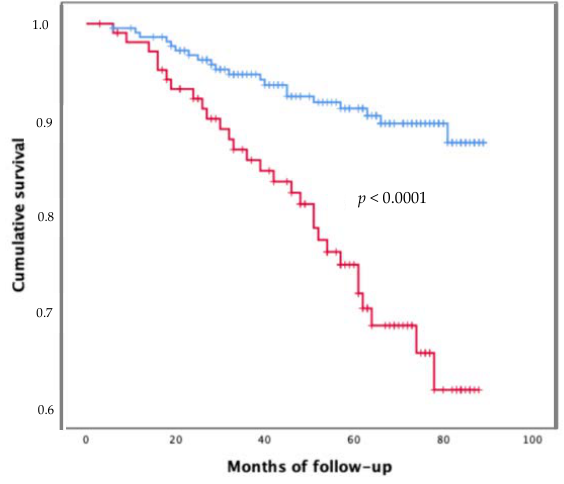
Figure 2. Survival curves of 324 C-P class A cirrhotic patients with gamma globulin < 1.8 gr/dl (blue line) and ≥ 1.8 gr/dl (red line).